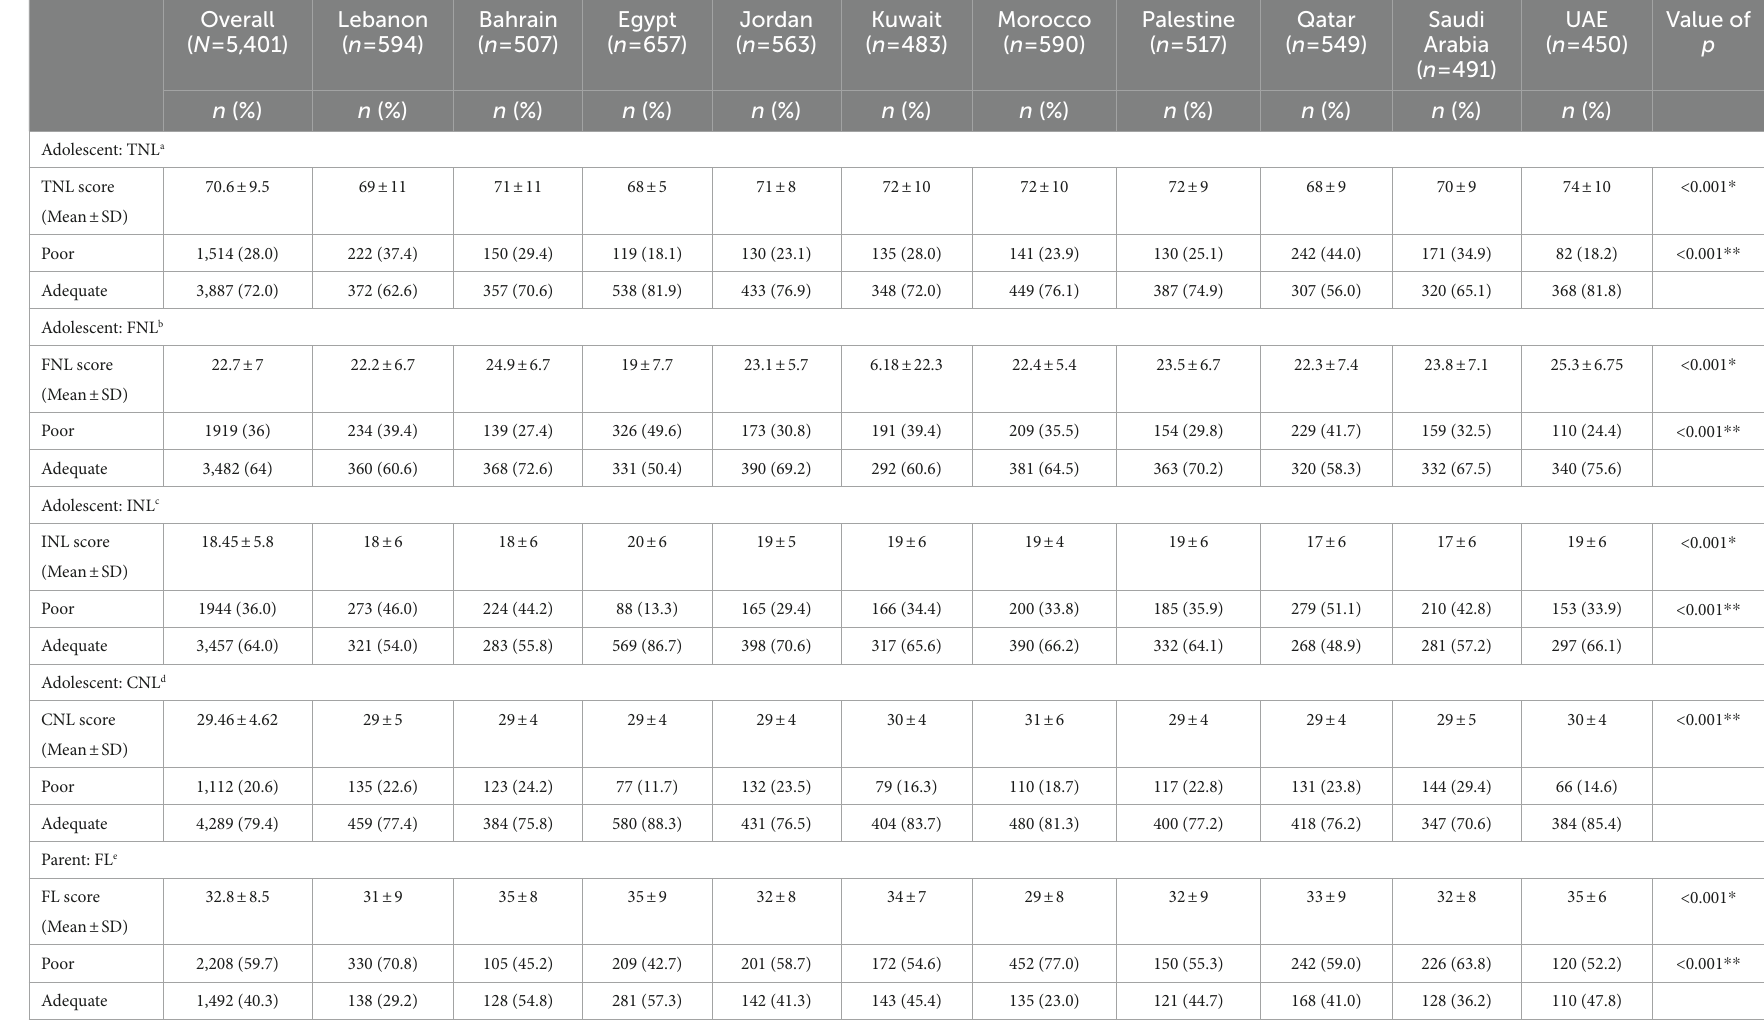
TABLE 3 The level of adolescents’ nutrition literacy and the food literacy of their parents, overall and by